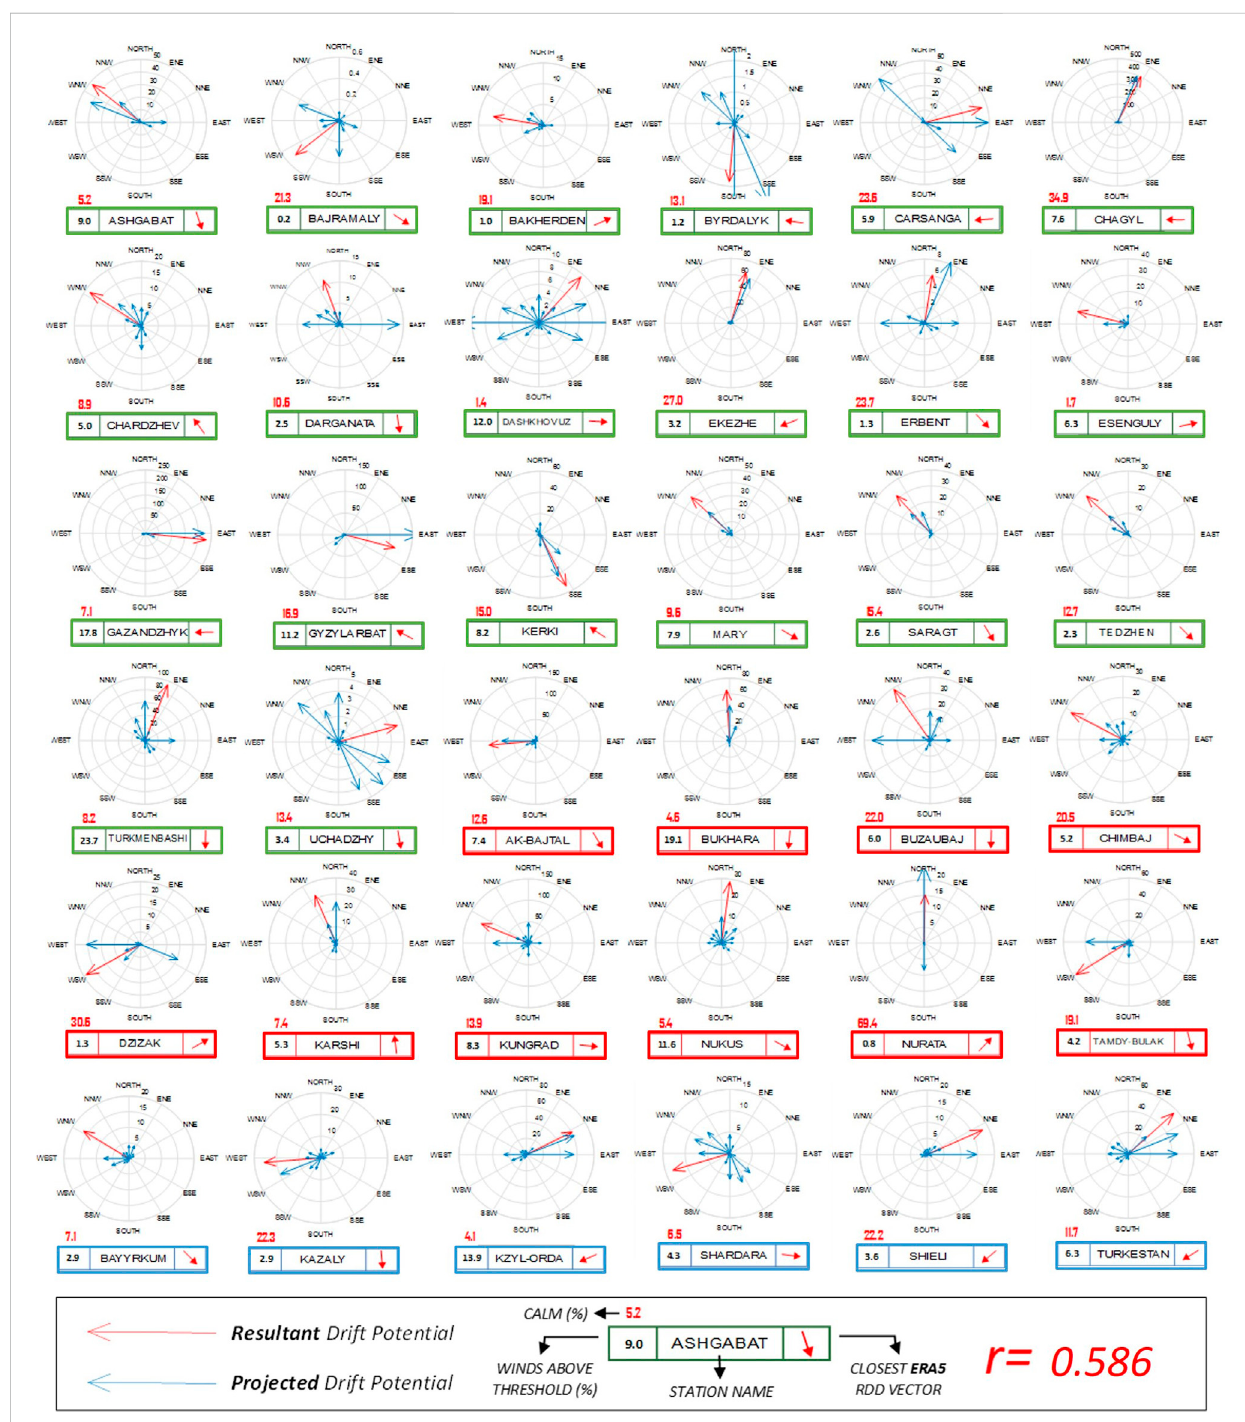
FIGURE 7 SandRosescorrelationfortheNationalOceanicandAtmosphericAdministration(NOAA)weatherstationsandthenearestERA5gridcontrolpoints. Circular and non-circular parameters are tested using number cruncher statistical systems (NCSS)